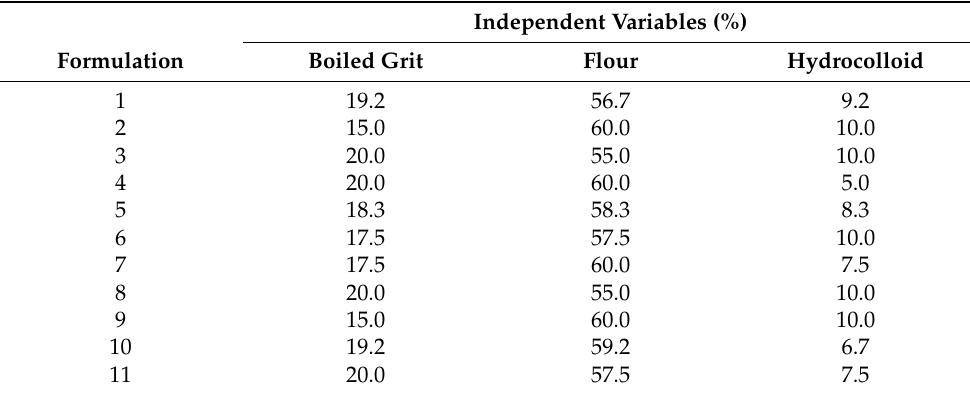
Table 1. D-optimal mixture design for instant egusi soup formulations. Independent Variables